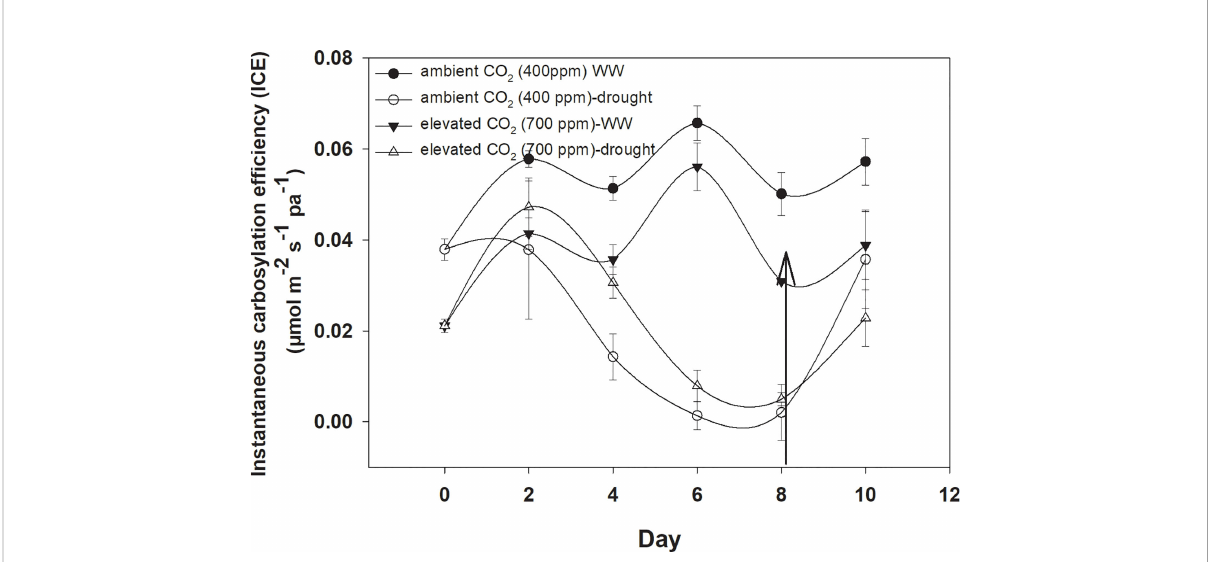
FIGURE 4 Effect of CO 2 concentrations and moisture conditions on instantaneous carboxylation ef fi ciency of Datura stramonium . The vertical line on the data point represents the standard error of the mean and the vertical arrow line after Day 8 represents the addition of water in the drought treatments. WW, well-watered.